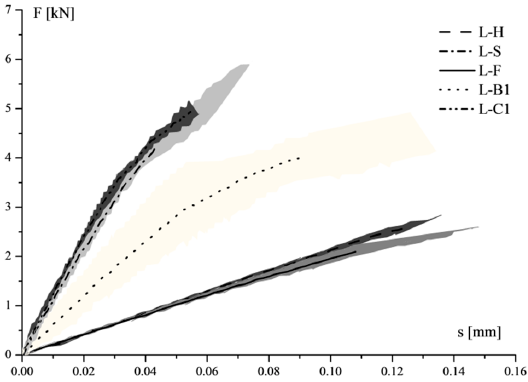
Figure 12. Average load–slip curves of shear bond tests on stone unit.